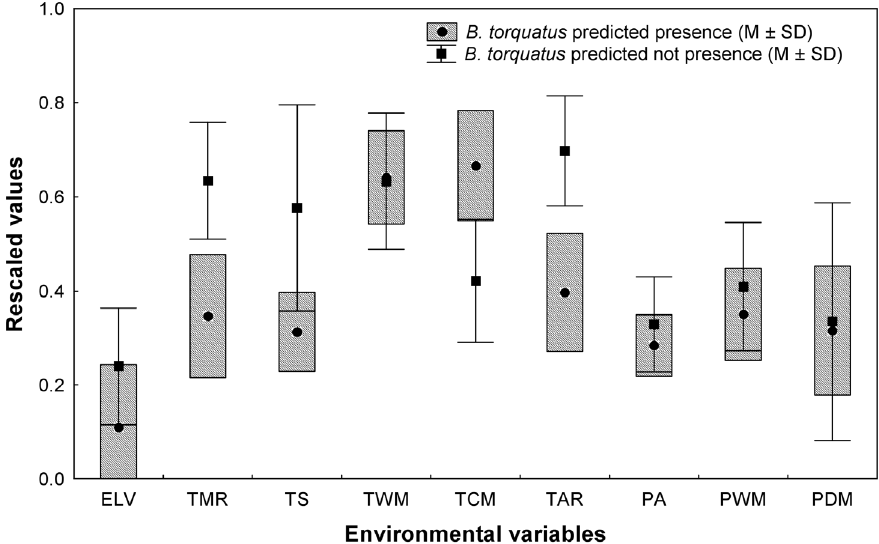
Figure 4. Rescaled environmental variables, representing predicted and not predicted values of presence of the maned sloth. Standardization of environmental variables to the same scale (0 to 1), based on the potential geographic distribution modeling for the Atlantic Forest. The whiskers represent the mean 6 standard deviation of the pixels from areas that the model did not predict the presence of maned sloth. The boxes represent the mean 6 standard deviation of the pixels from predicted suitable areas for the presence of maned sloth. Elevation (ELV), mean monthly temperature range (TMR), temperature seasonality (TS), maximum temperature of warmest month (TWM), minimum temperature of coldest month (TCM), temperature annual range (TAR), annual precipitation (PA), precipitation of wettest month (PWM) and precipitation of driest month